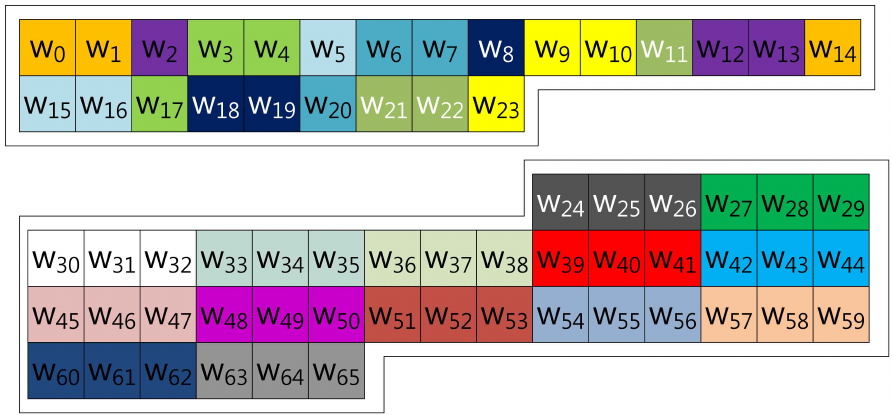
Figure 11. Look-up table structure of the (hybrid) proposed method in block form for 3NAF (version